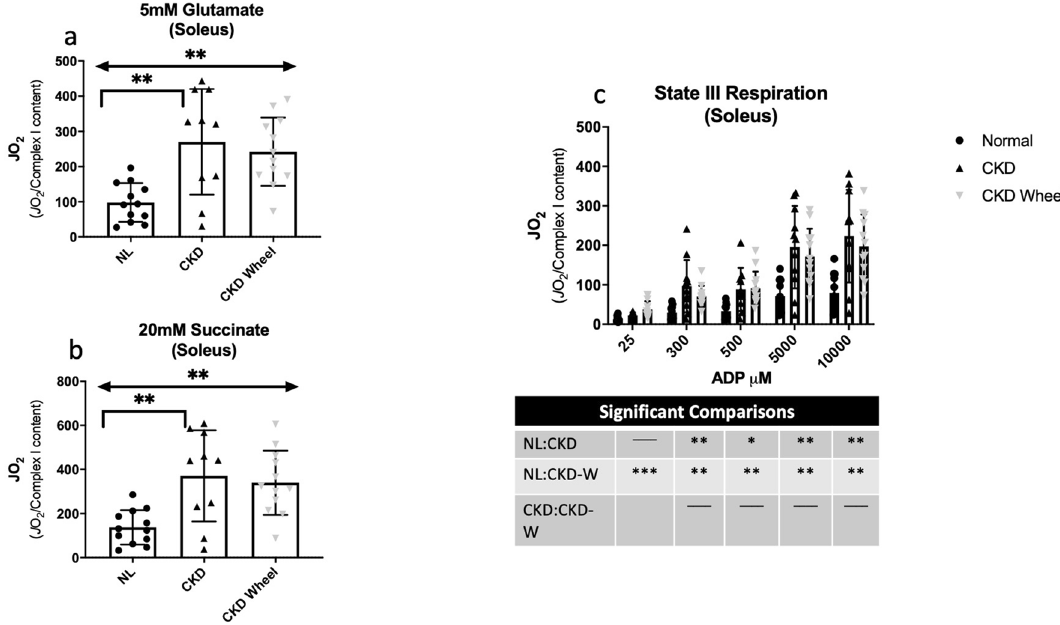
Figure 7. Soleus mitochondrial respiration demonstrated increased respiration in CKD that was not altered by wheel running. ( a ) Maximal ADP-stimulated respiration was increased for CKD soleus as compared to NL, but no difference between CKD and CKD-W with the addition of 5 mM glutamate. ( b ) Complex I + II-supported respiration was similarly increased in CKD as compared to NL, and was not impacted by wheel running following the addition of 20 mM succinate. ( c ) ADP-stimulated respiration (state III) in the soleus was increased in CKD as compared to NL, but was not altered by wheel running . Data are shown as mean ± SD (n = 9–12 rats each group). * p < 0.05, ** p < 0.01, *** p < 0.001. ⎴ (NL vs. CKD comparison); ← → (NL vs. CKD-W comparison); l—l (CKD vs. CKD-W